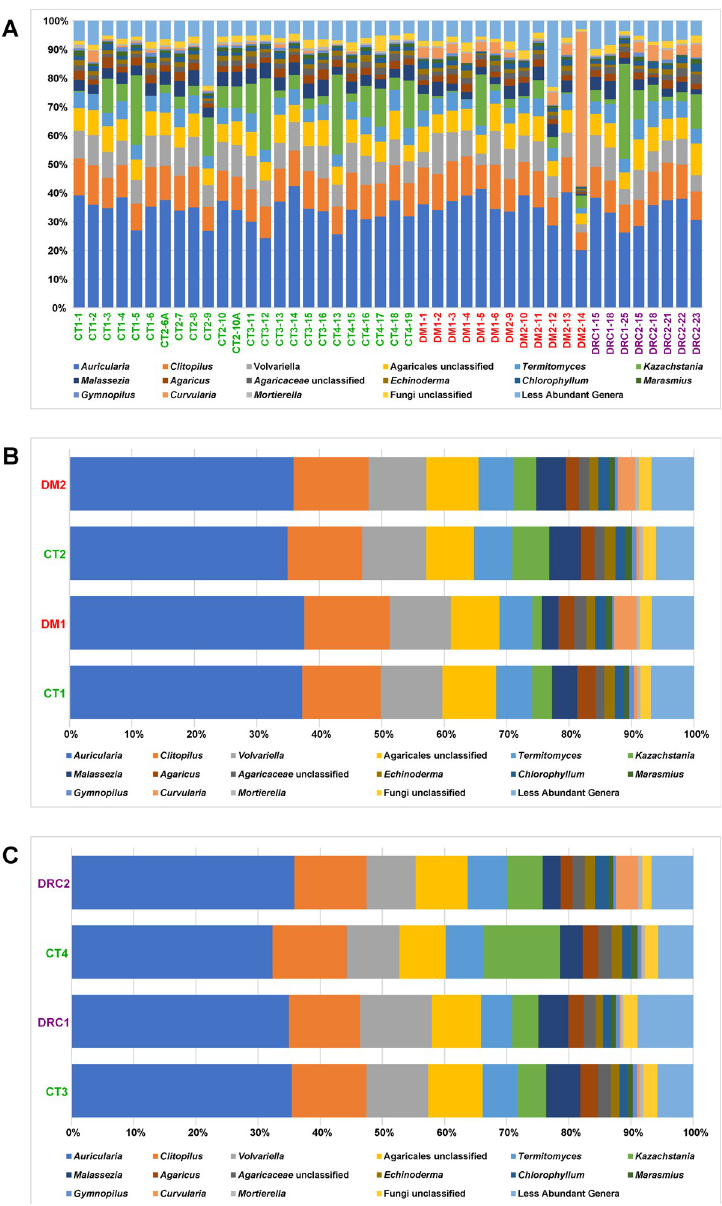
Fig 3. A. Changes in the abundance (%) of genera in the gut mycobiomes of control (CT1, n = 6; CT2, n = 6; CT3, n = 6; CT4, n = 6), diabetic (DM1, n = 6; DM2, n = 6) and diabetic rats showing retinal changes (DRC1, n = 3; DRC2 n = 5). B. Comparison of median abundance (%) of fungal genera from gut mycobiomes of control (CT1, n = 6; CT2, n = 6) and diabetic (DM1, n = 6; DM2, n = 6) rats and C. between control (CT3, n = 6; CT4, n = 6) and diabetic rats showing retinal changes (DRC1, n = 3; DRC2 n =